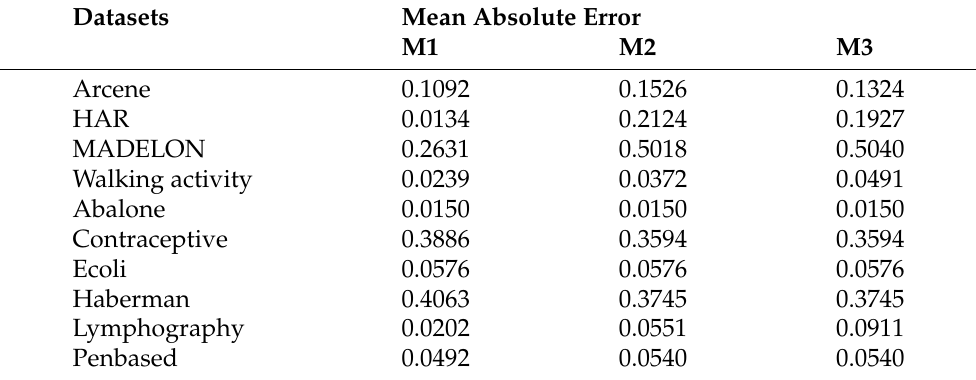
Table 9. Mean absolute error of the proposed work with neural network classifier.